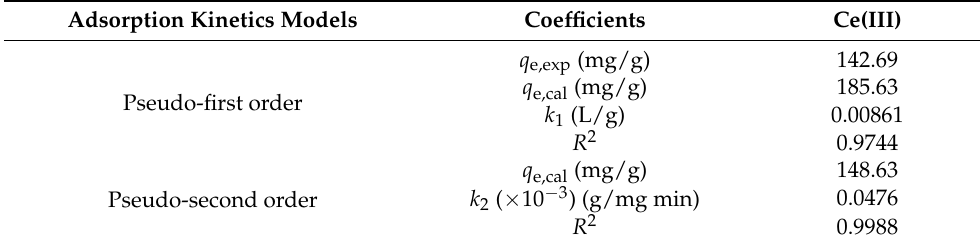
Table 2. Kinetic parameters of Ce(III) on magnetic PMMA-PGMA-PEI at 298.15 K. Adsorption Kinetics